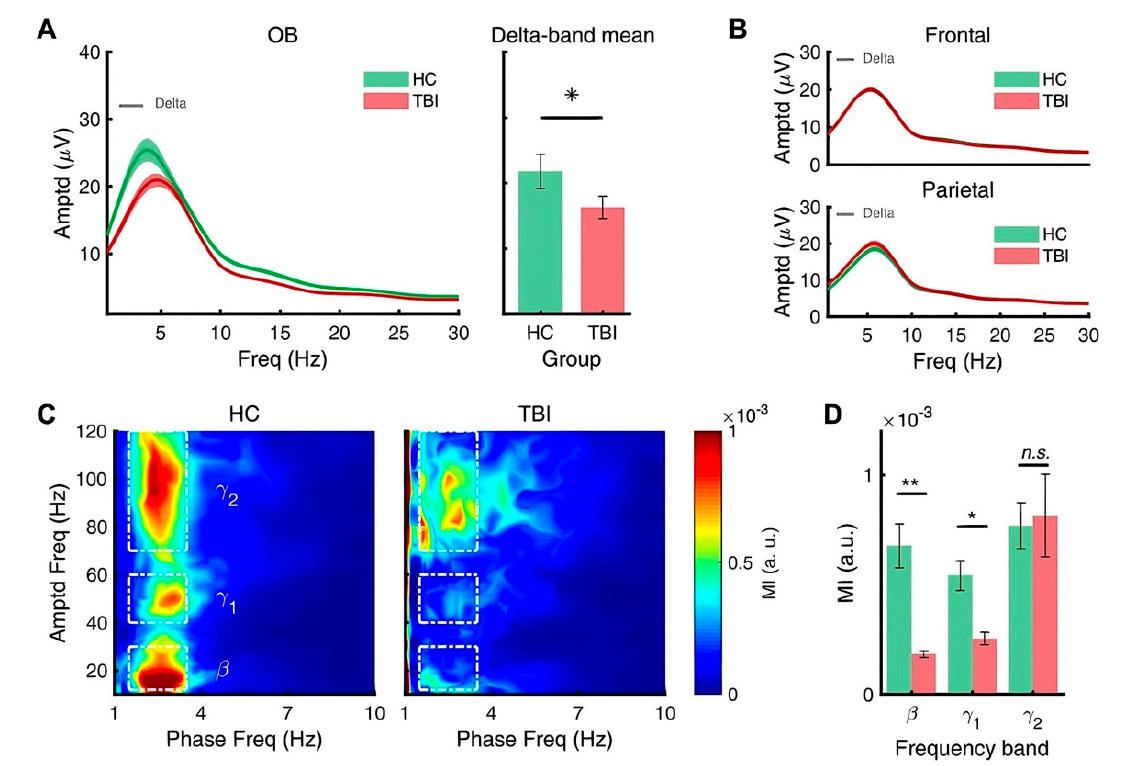
Figure 6. Olfactory bulb exhibits reduced delta oscillations and modulation index by repetitive TBI. ( A ) Resting state phase amplitude analysis in the olfactory bulb. There was a decrease ( p = 0.0309) in resting state delta ‐ band amplitude in TBI mouse models. ( B ) There was no significant amplitude change observed at the frontal and parietal regions of the mouse brain. ( C ) Comodulogram comparing healthy and TBI mouse subjects’ cross ‐ frequency coupling with delta bands. TBI mouse models showed reduced cross ‐ frequency coupling in delta–beta and delta–theta1 phase pairs. ( D ) Statistical analysis illustrating lowered MI of delta–beta ( p = 0.0077) and delta–theta ( p = 0.0289) oscillation pairs of TBI mouse models. Error bars indicate SEM. Significantly different from control at * p < 0.05 and ** p < 0.01.